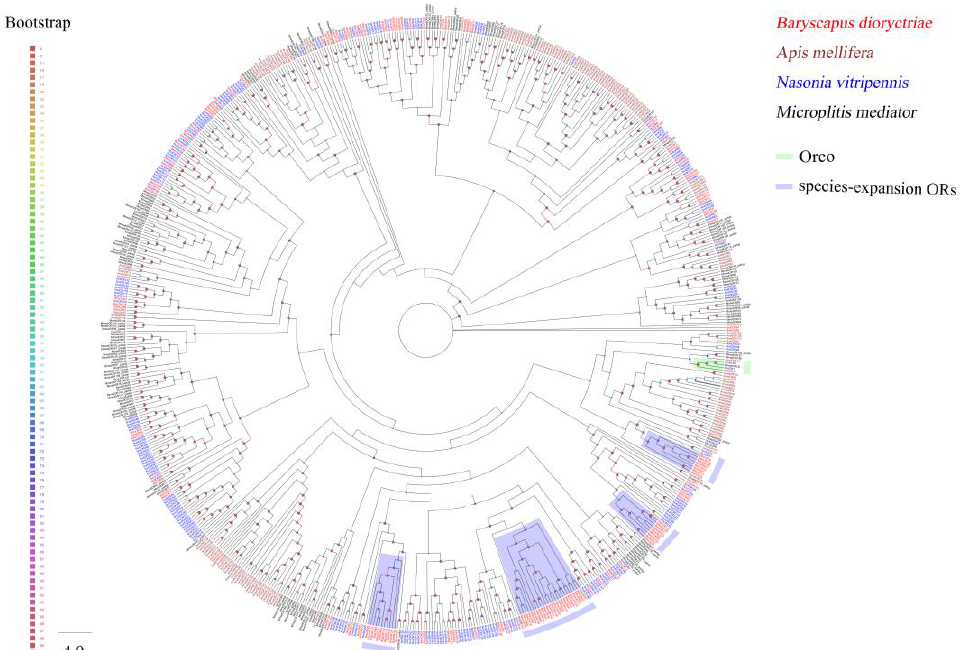
Figure 4. Phylogenetic tree of 705 odorant receptors (ORs) from B. dioryctriae and three other Hymenoptera species. The protein sequences used in this phylogenetic analysis are listed in the Supplementary Materials (File S4). The size and color of the dots reflect their bootstrap values. The color scale is shown on the left, with larger dots indicating larger bootstrap values.